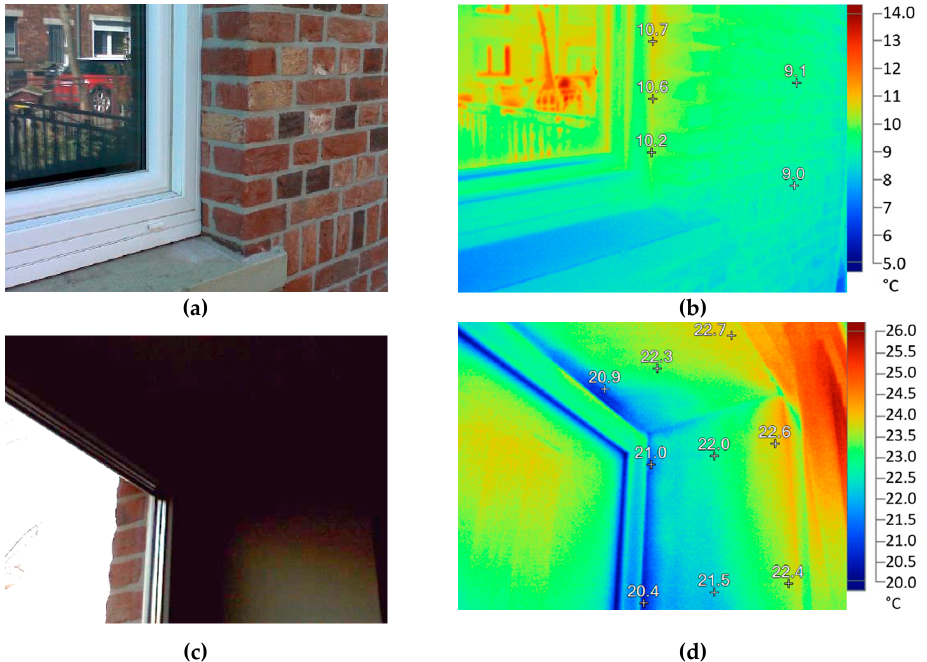
Figure 4. Infrared scan of the building. Top: Air leaks around the window frames connecting the outside and the air cavity—seen from the outside with the building under positive pressure. ( a ) Exterior photo and ( b ) Infrared image. Bottom: Air leaks around the window frames connecting the outside and the air cavity – seen from the inside with the building under negative pressure. ( c ) Interior photo and ( d ) Infrared